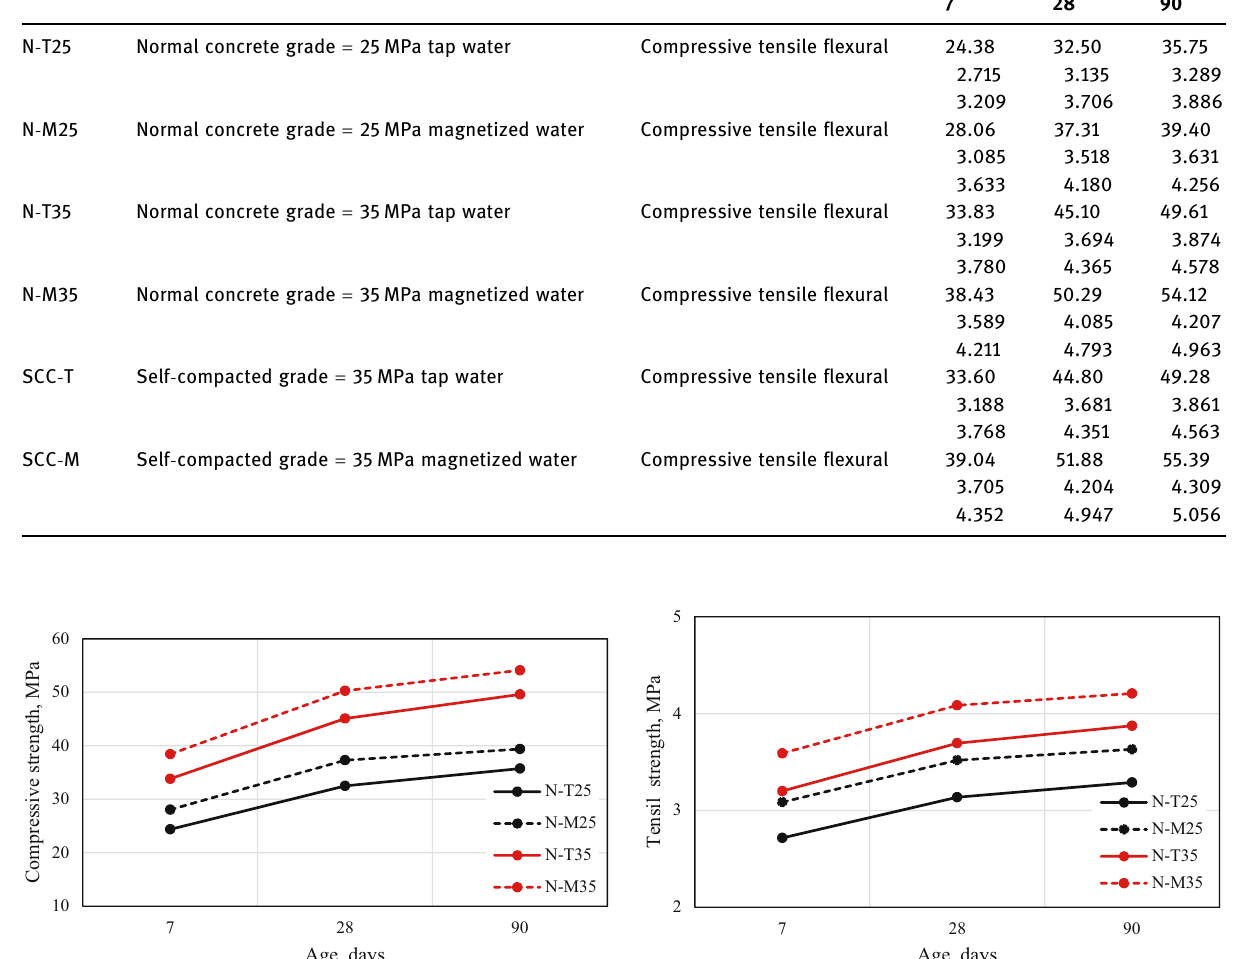
Figure 4: Compressive strength results for normal mixes using tap and magnetized